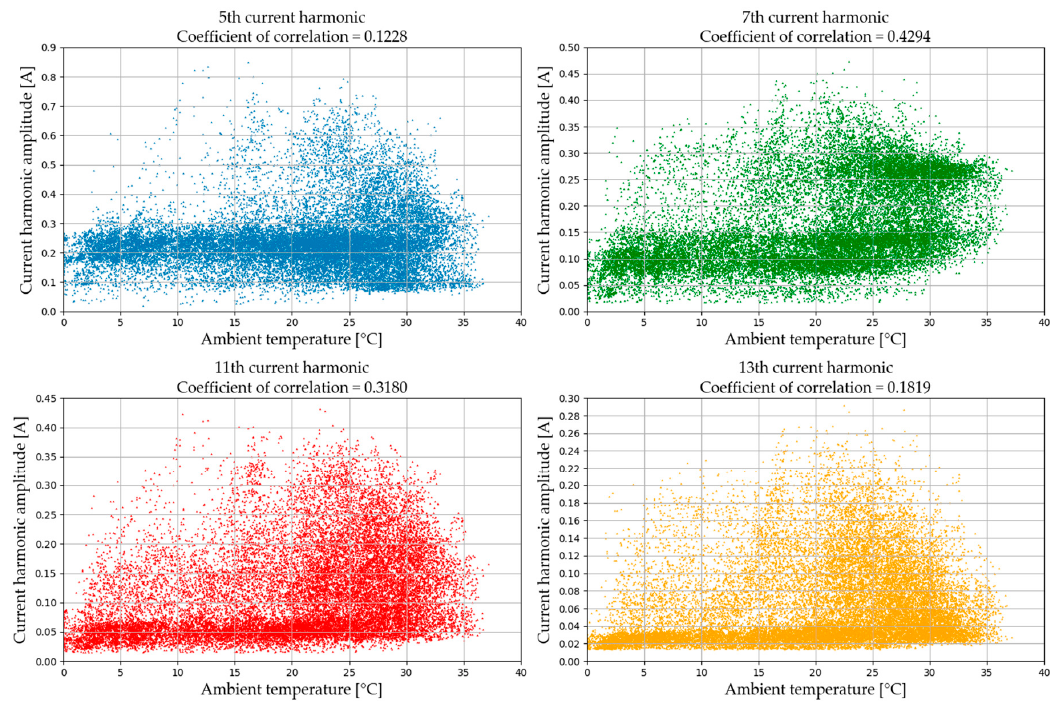
Figure 9. 5th, 7th, 11th, and 13th current harmonic amplitudes in relation to ambient temperature.